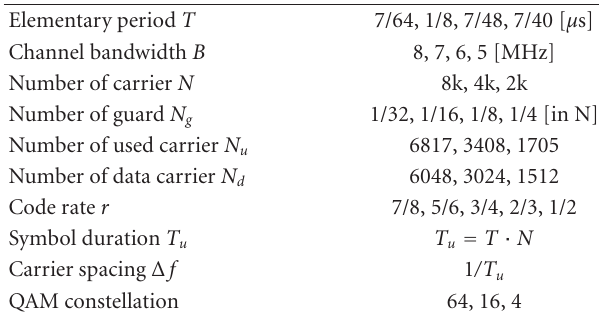
Table 1: DVB-T/H system parameters (see